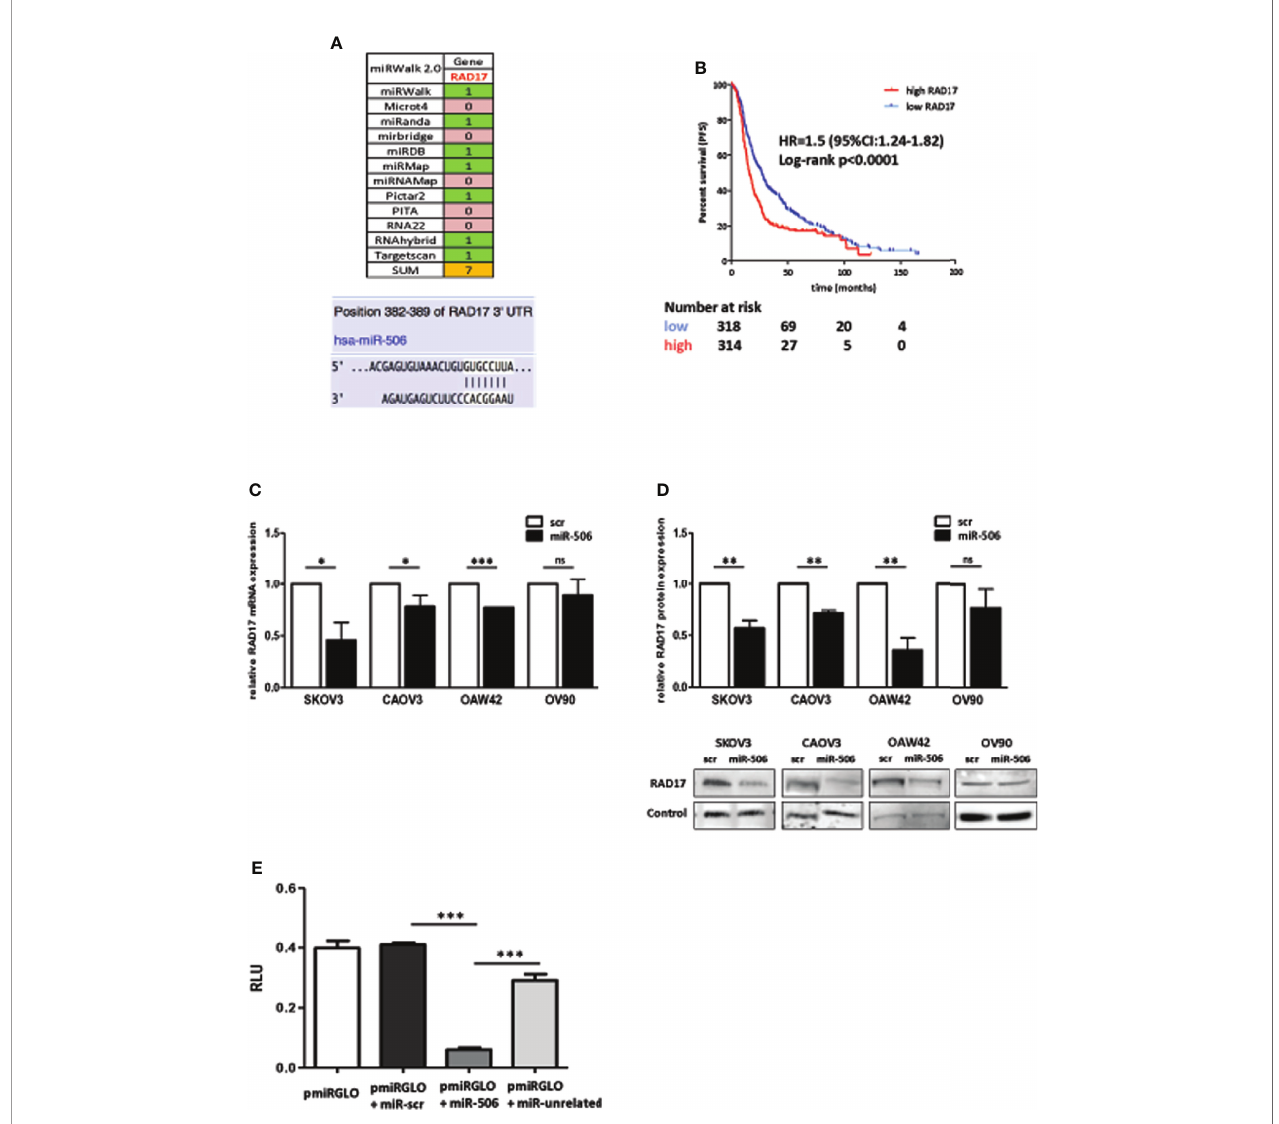
FIGURE 2 | RAD17 is a target of miR-506-3p and associates with worse prognosis in EOC patients. (A) List of algorithm challenged with MirWalk2.0, with the prediction of miR506-3p targeting on RAD17 3 ’ UTR. 0 = absence 1 = presence of a seed region for miR-506-3p in the 3 ’ UTR of RAD17 . Lower panel: images from microRNA.org and TargetScan prediction tools showing the alignment of miR-506-3p within the predicted binding site in the RAD17 3 ’ UTR. (B) Kaplan-Meier survival curves of EOC patients strati fi ed according to RAD17 transcript expression. Data were extracted and analyzed with KM-plotter software (26). Progression free survival time was the clinical end-point analyzed. Data derived from 10 different publicly available datasets (GSE14764, GSE15622, GSE26193, GSE26712, GSE30161, GSE32062, GSE51373, GSE63885, GSE9891, TCGA) and selecting for patients treated with a Pt-based therapy. A total of 1291 patients were included in the analysis and strati fi ed according to RAD17 (207405_s_at probe) quartile expression. (C, D). Four EOC cell lines (SKOV3, CAOV3, OAW42, and OV90) were transfected with miR-506-3p mimic (miR-506) or scrambled control miR (scr). RAD17 expression was analyzed by qRT-PCR (C) to check RAD17 mRNA and by Western blot (D) to check RAD17 protein expression levels. Bar charts represent the ratio of down-regulation of RAD17 mRNA (C) or protein (D) expression in miR- 506-3p versus scr transfectants taken as reference of expression for each cell line. RNU48 and RNU44 were used for normalization in qRT-PCR assay. For western blot analysis loading control was b -actin for SKOV3, OAW42, OV90 cells and vinculin for CAOV3 cells. Student ’ s t-test was used to compare miR-506 versus scr cells (*p<0.5; **p<0.01;*** p<0.001; ns = not signi fi cant). (E) Dual-Luciferase Reporter assay con fi rming RAD17 as a direct target of miR-506-3p. HEK293T cells were transfected with pmiRGLO empty vector (pmiRGLO, white bar), or pmiRGLO containing the putative binding site of miR-506-3p in the RAD17 3 ’ UTR in combination with a scrambled miRNA (scr) (pmiRGLO+miR-scr, black bar), miR-506-3p (pmiRGLO+miR-506-3p, gray bar) and an unrelated miRNA (pmiRGLO+miR- unrelated, dotted bar). Results are the ratio (Fire fl y/Renilla) of Relative Luminometer Units (RLU). Student ’ s t-test was used to compare t-miR506 versus t-scr or t- miR-unrelated cells (***